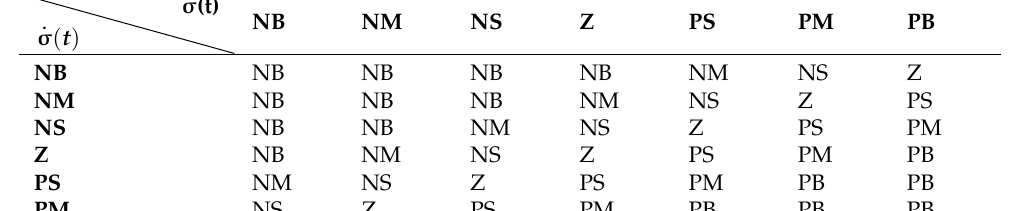
Table 1. Rule matrix for T1F-SFOSMC and proposed T2F-SFOSMC.